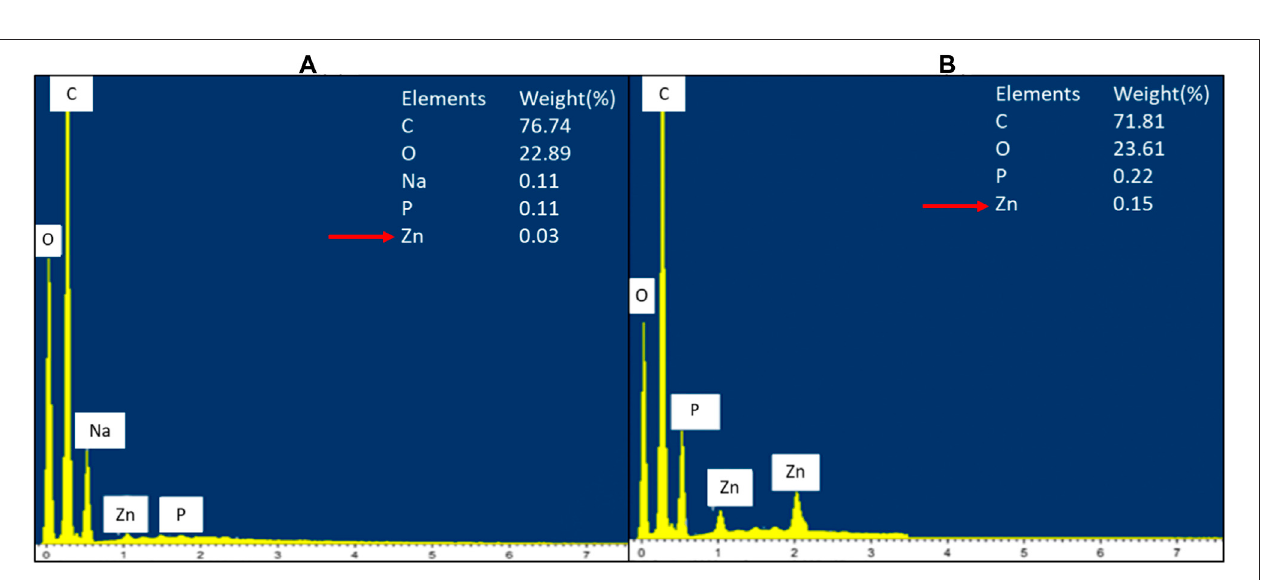
FIGURE 9 | EDX spectrum of negative control of S. marcescens (A) and S. marcescens after treatment with 160 μ g/ml of ZnO NPs for 24 h (B) .